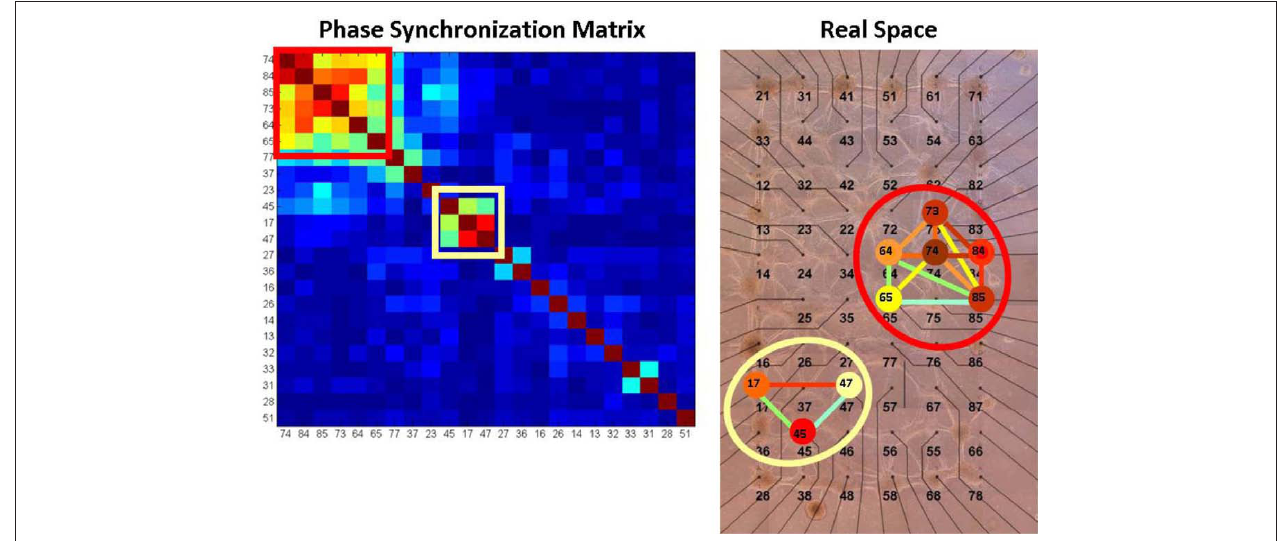
Figure 8 | Projection of the synchronization networks and node centrality on real space. The picture on the left shows a dendrogramed synchronization matrix and the picture on the right shows the real space mapping of its corresponding synchronization network. In this example of WT